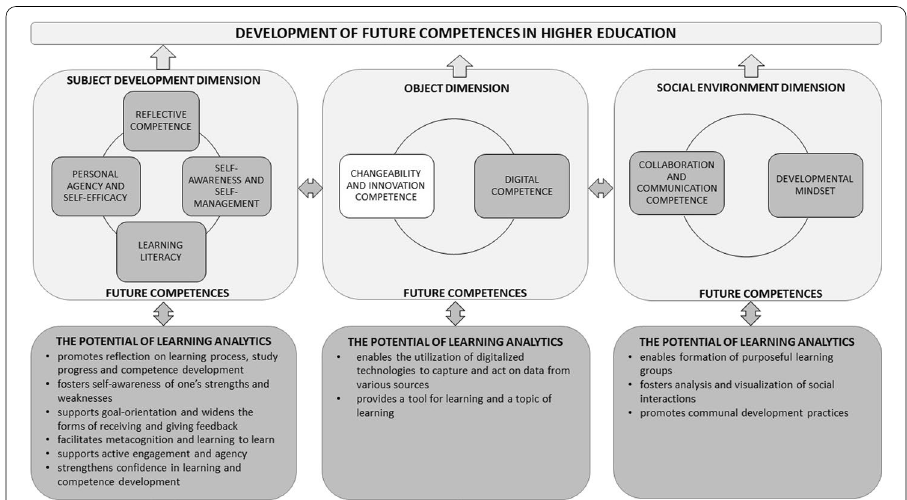
Fig. 2 Supporting the development of future competences through learning